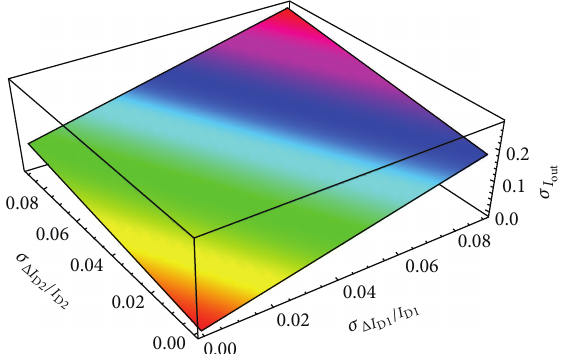
Figure 5: The core circuit of the subthreshold FGMOSFET based OTA proposed in [11].